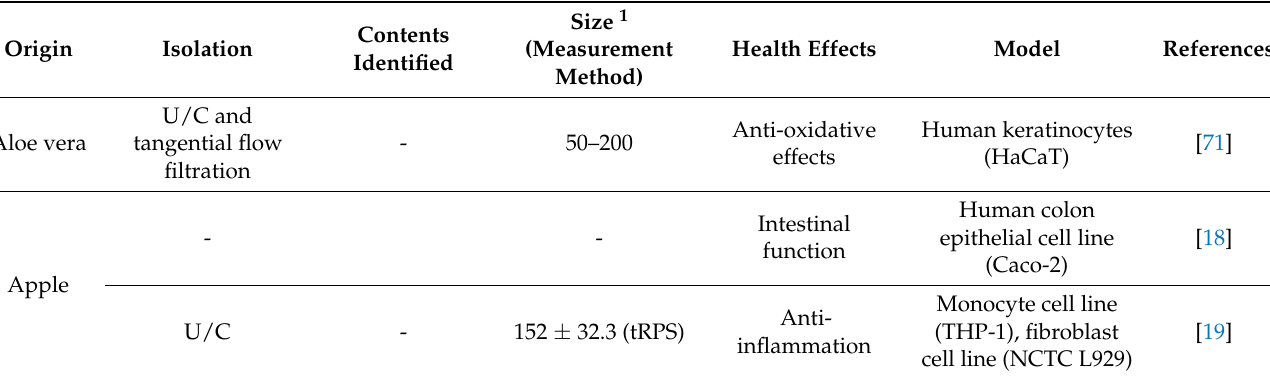
Table 2. Health benefits of natural